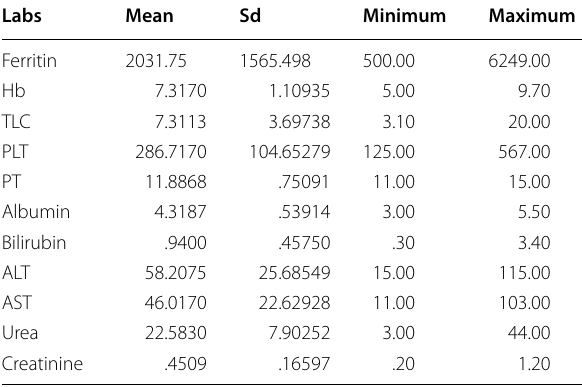
Table 2 Laboratory characteristics of the studied